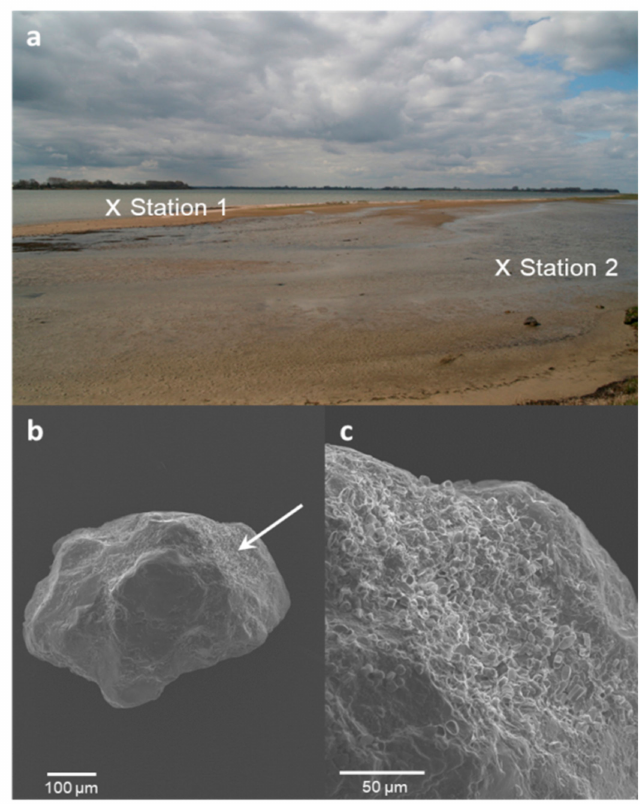
Figure 5. Typical picture of the sheltered sampling site at Boiensdorf on 17 April 2012 ( a ). Both sites S1 and S2 differ in the average water depth (see Table 1). Scanning electron microscopic images of sandy particles with epipsammic diatoms from this protected site ( b , c ). The sand grains are angular shaped with many edges carrying high numbers of small, attached diatoms (<10 µ m), which formed dense